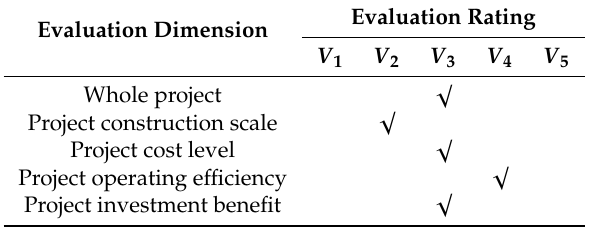
Table 6. The evaluation rating of each evaluation dimension (Project